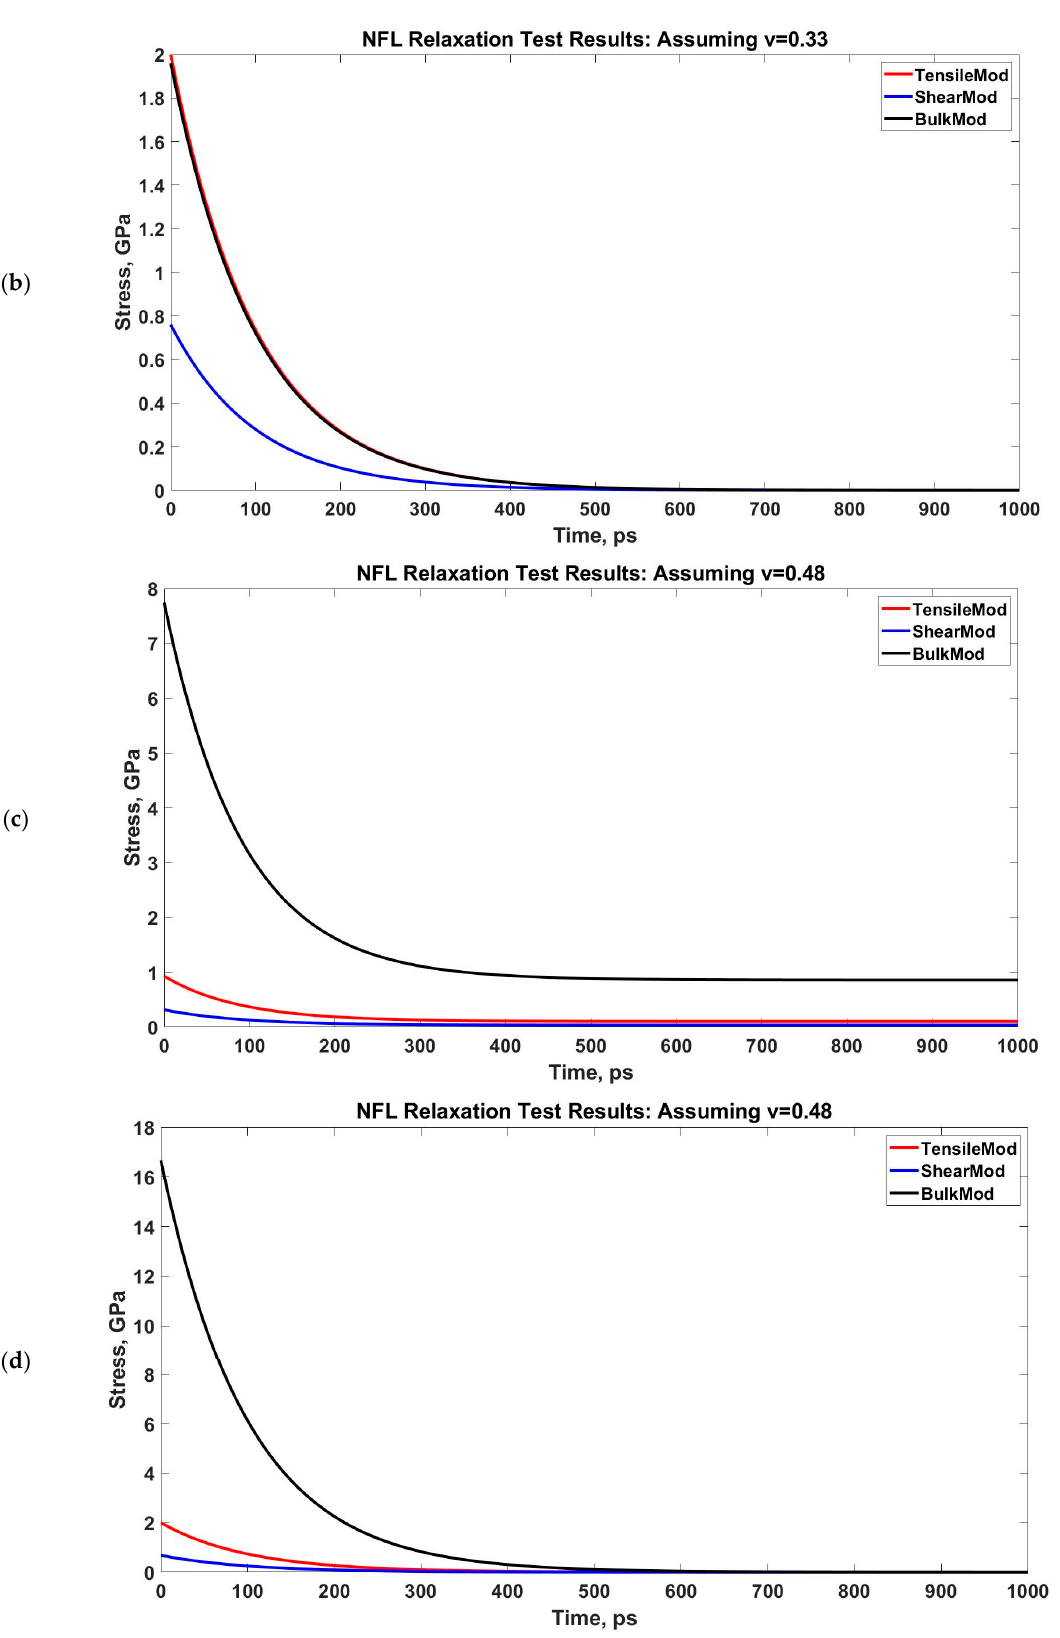
Figure 6. Determining G(t) and K(t) from E(t) for two assumed Poisson’s ratios. The NFL relaxation response is obtained for two strain rates: 1 × 10 8 /s and 1 × 10 9 /s. ( a , b ): 1 × 10 8 /s, ( c , d ): 1 × 10 9